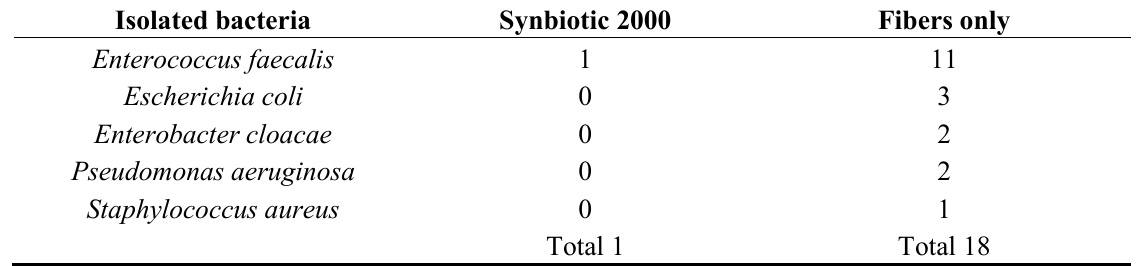
Table 8. Pathogens isolated from patients undergoing liver transplantation treated with Synbiotic 2000 and only the fibers in Synbiotic 2000, respectively